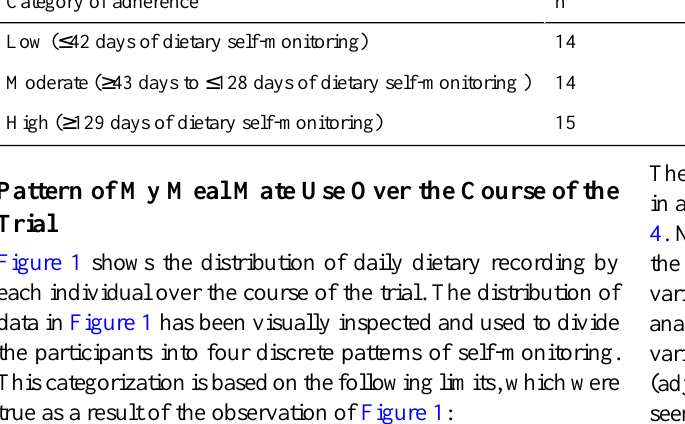
Category of frequency of My Meal Mate use (days of dietary self-monitoring)Participant characteristic